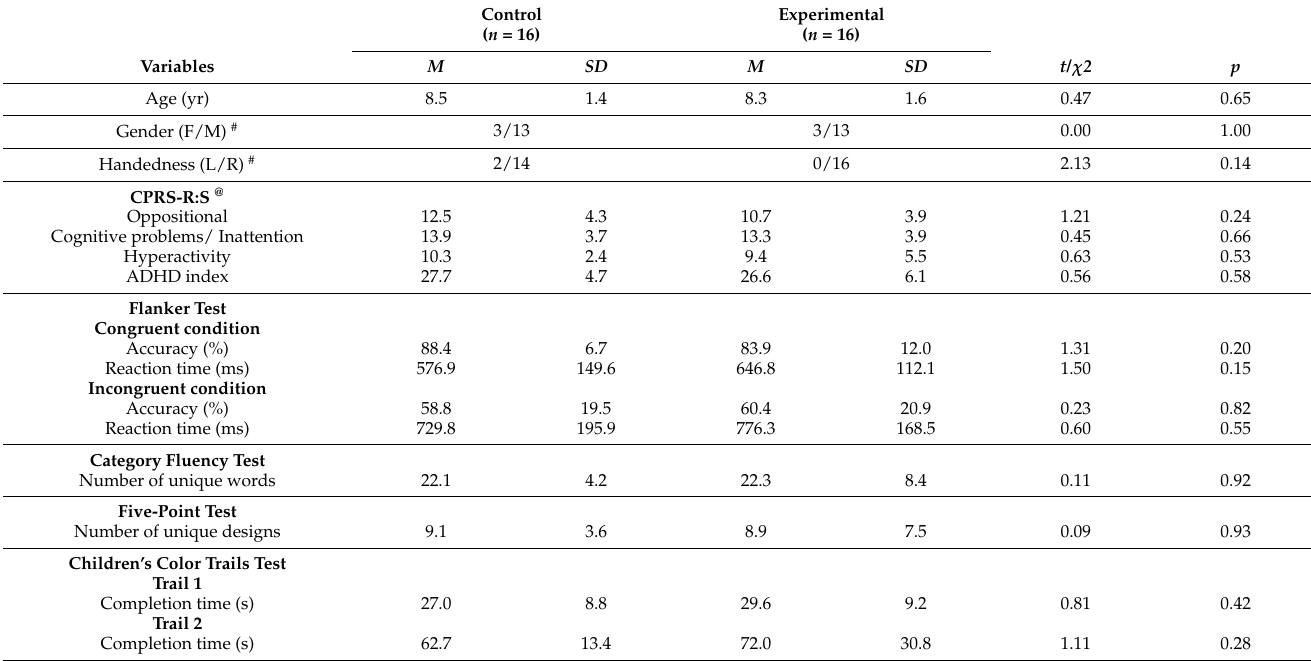
Table 1. Demographics, clinical symptoms, and baseline task performance of the experimental ( n = 16) and control groups ( n =